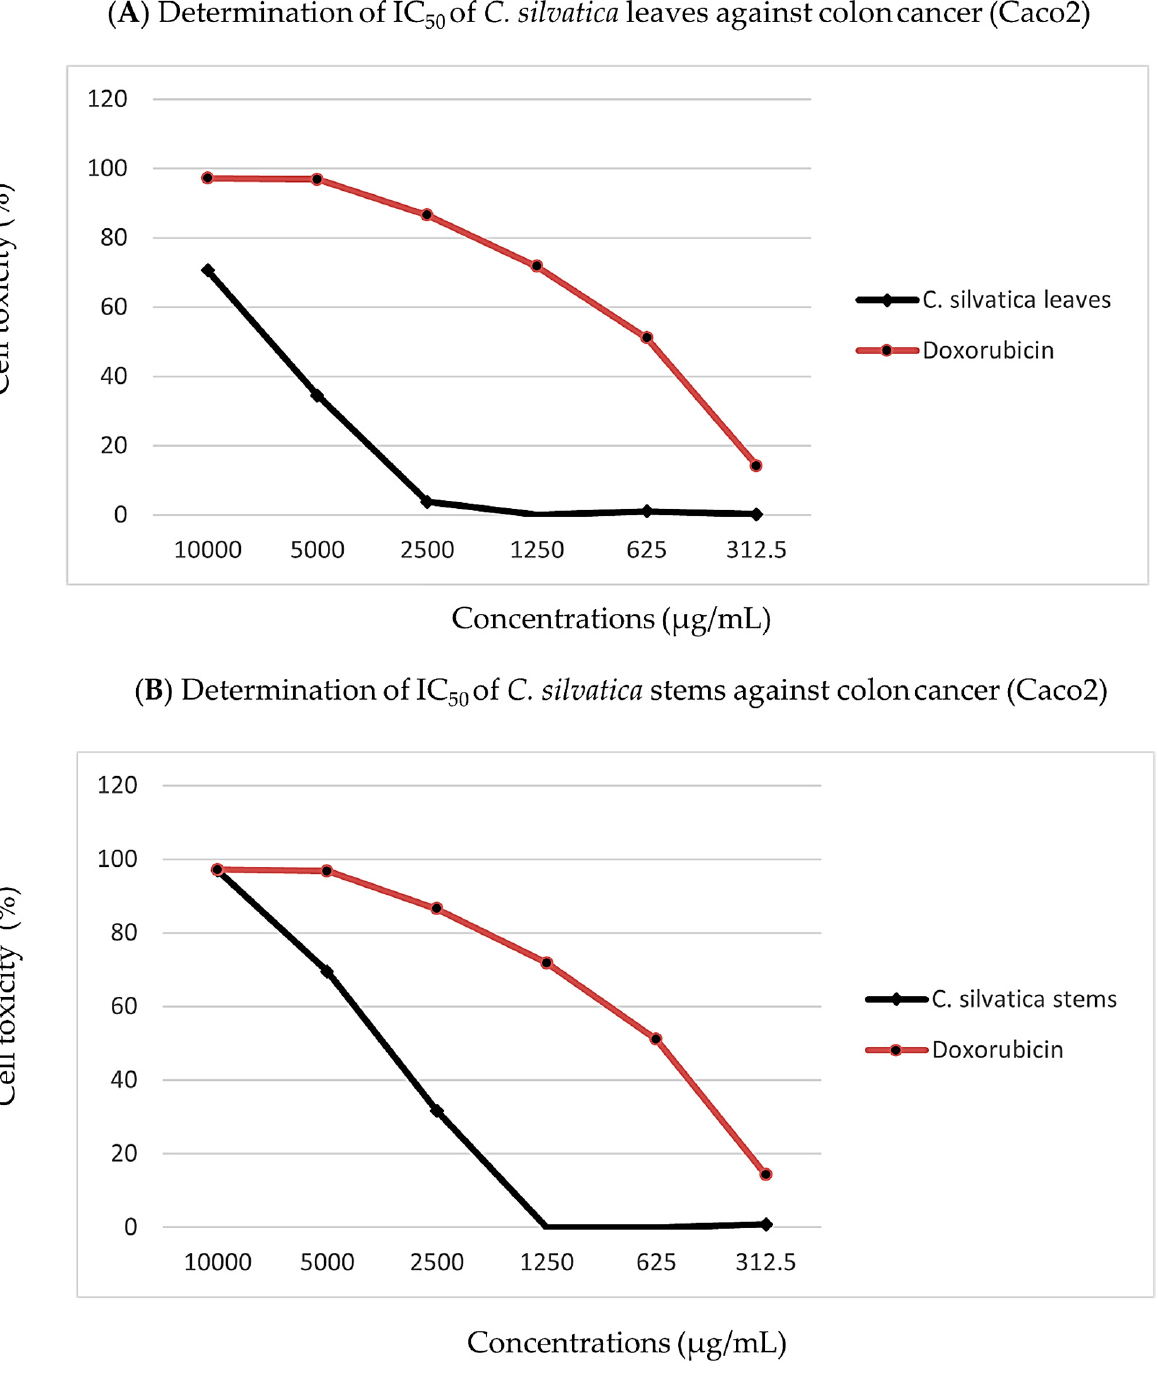
Figure 4. Determination of the half-maximal inhibitory concentration (IC 50 ) of ( A ) C. silvatica leaves extract and ( B ) C. silvatica stems extract against colon cancer (Caco2).